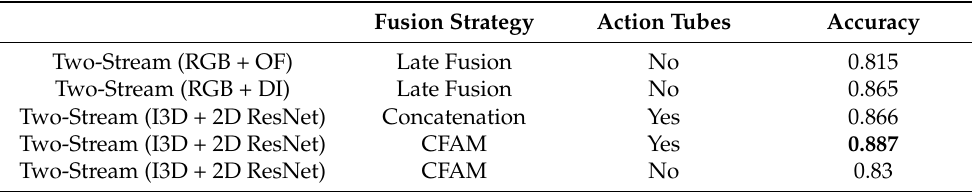
Table 6. Ablation study of different variants of two-stream models with different fusion strategies. We report the classification accuracy on the RWF-2000 validation set.